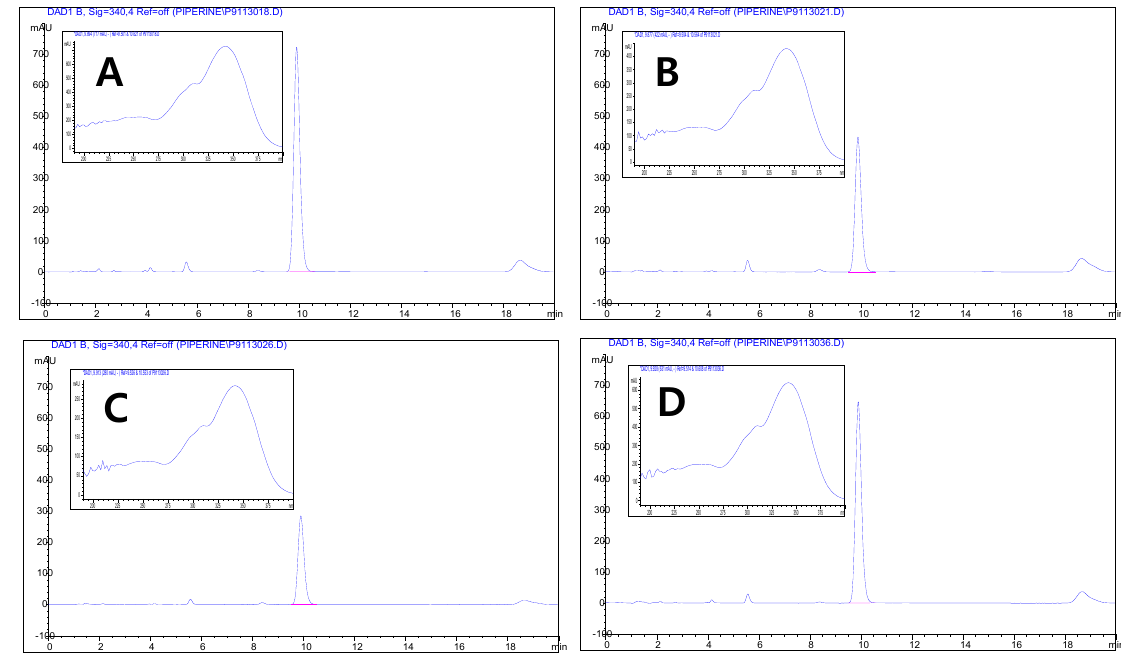
Figure 1. Chromatogram and absorption spectra of GPI (A), GPS (B), BPI (C), and BPS (D).